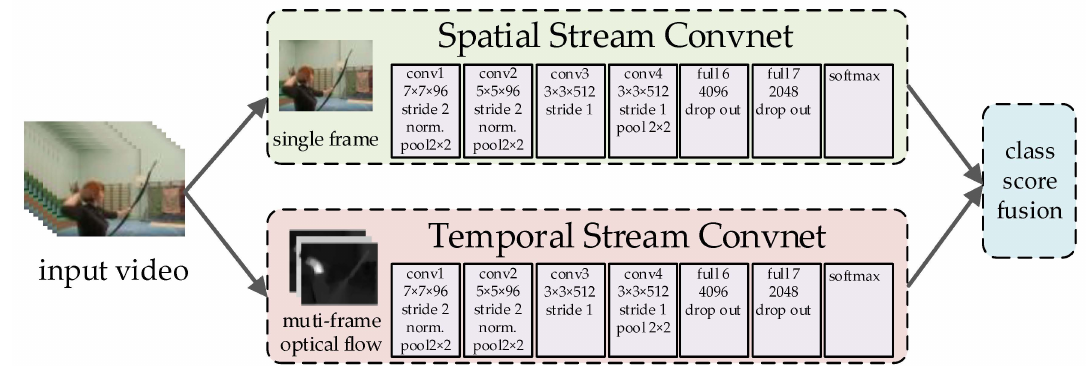
Figure 3. Two-stream network architecture.